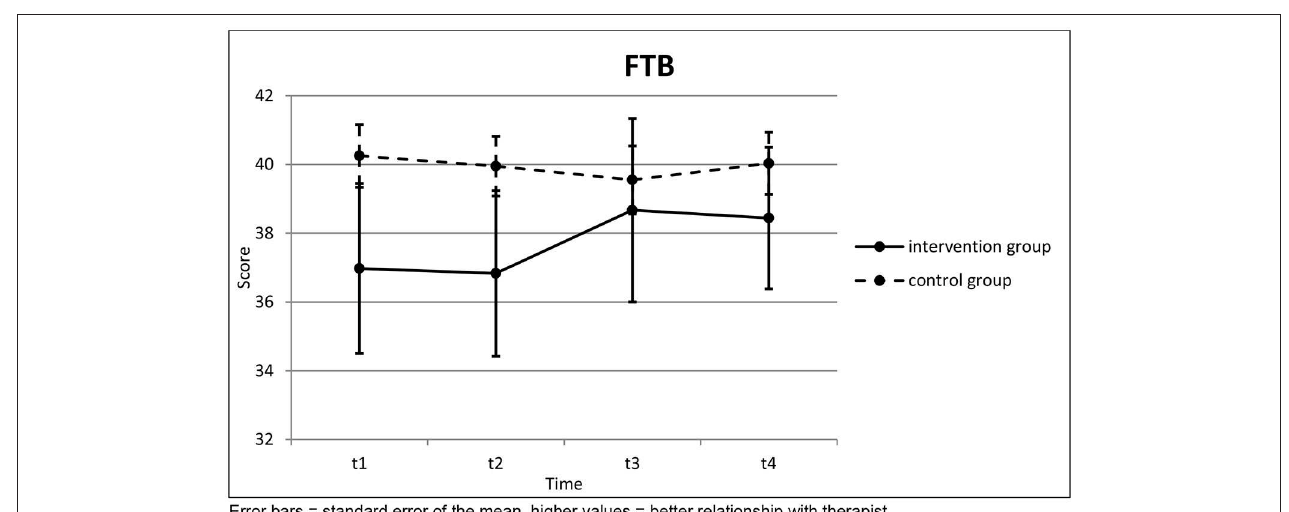
FIGURE 4 | Questions about the Therapeutic